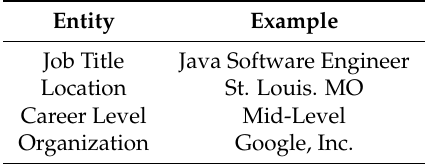
Table 4. Entities along with examples from a job description in SAJ.